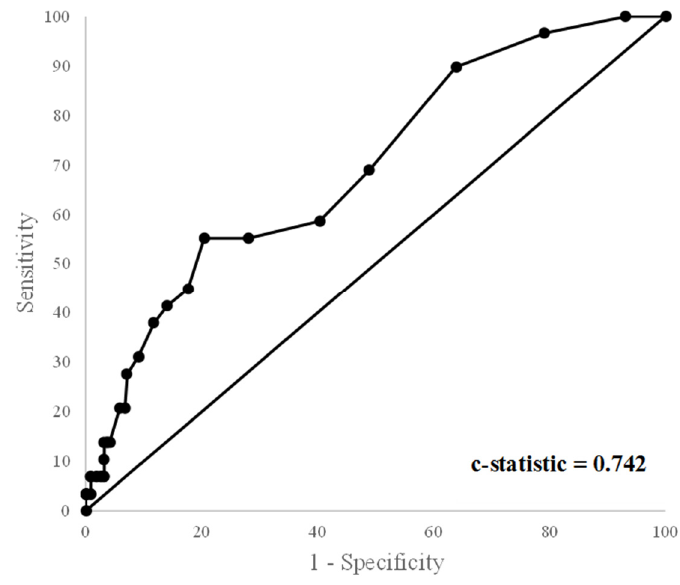
Figure 2. Receiver operator characteristic Curve for multivariable model.